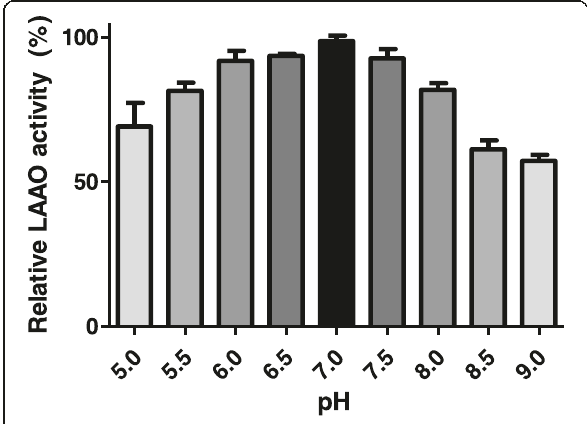
Fig. 4 pH profile of LAAO activity. Crotalus durissus terrificus crude soluble venom, horseradish peroxidase, OPD and L-leucine were incubated in different 0.05 M buffers, at different pHs (5.0 to 9.0), for 60 min at 37